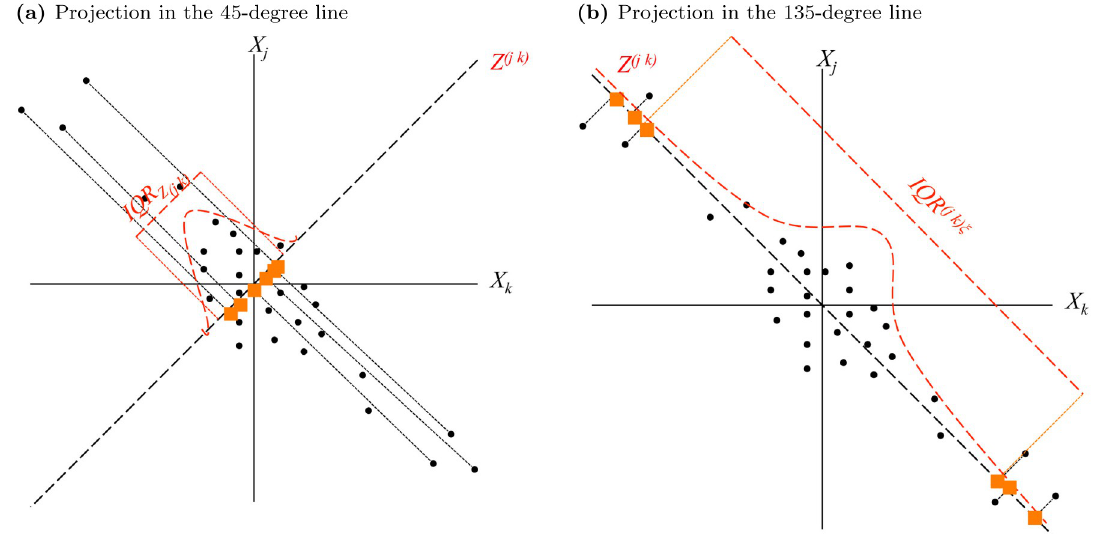
Fig 2. A diagrammatic representation of TailCoR for negative relation. Scatter plots where X projection is done with the wrong and right angles (panels (a) and (b) respectively).